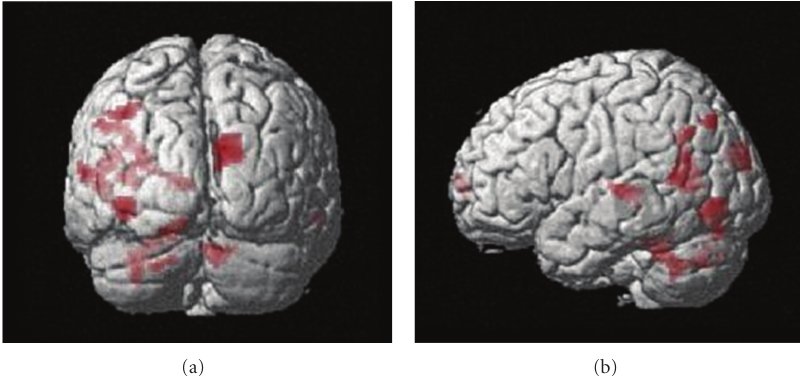
Figure 2: Posterior (top) and right lateral (bottom) views of the group activation map showing increased di ff erential activity after the facilitation programme, for the contrast between past and control conditions ( P = 0 . 01, k > 20).